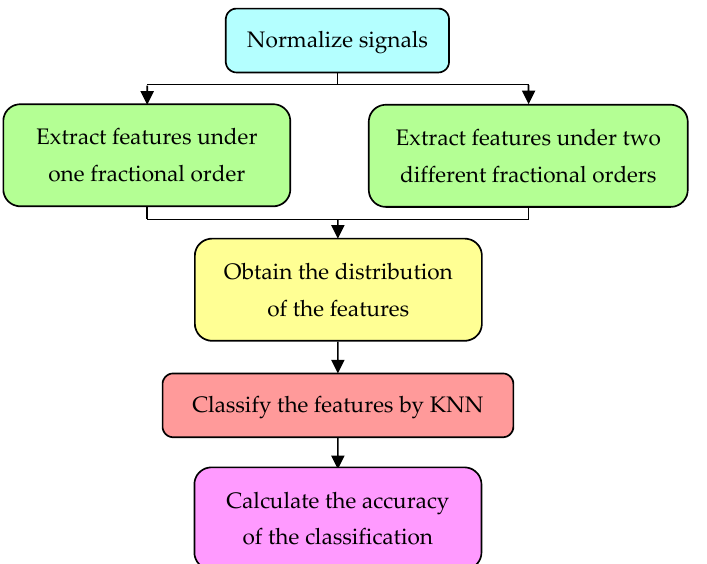
Figure 3. The flowchart of the proposed feature extraction methods.